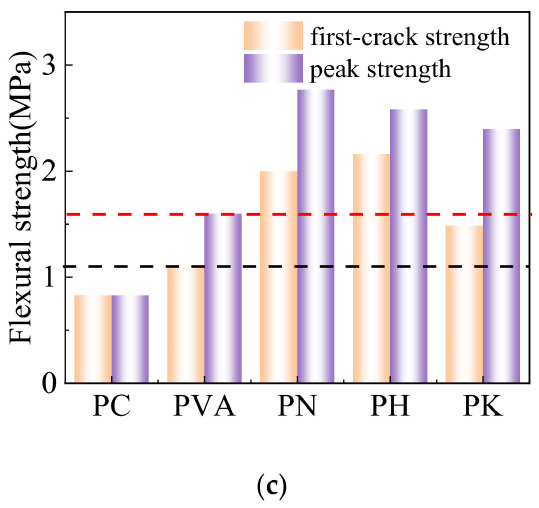
Figure 5. Flexural strength of cemented soil before and after modification with fiber contents of 0.25% ( a ), 0.5% ( b ) and 1% ( c ).